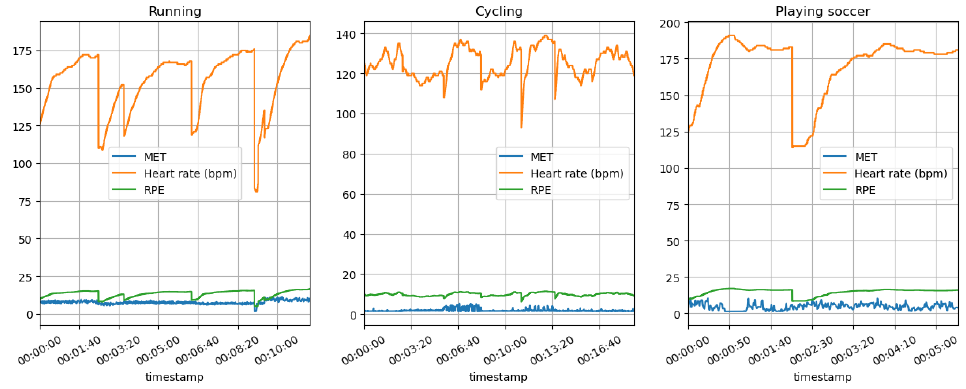
Figure 7. HR, MET, and RPE per sport.